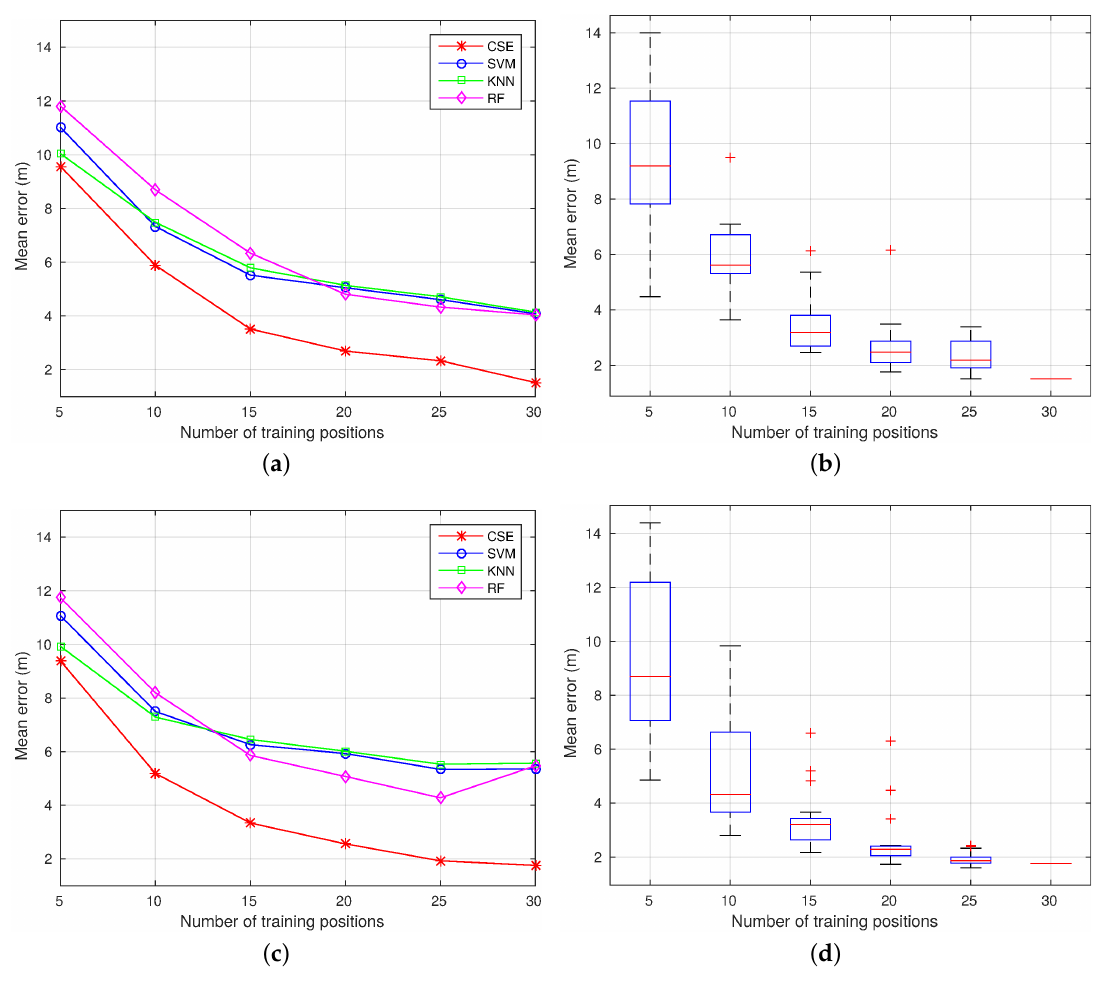
Figure 14. Mean error evolution changing the number of randomly-selected training positions. ( a ) Trajectory 1: mean error; ( b ) Trajectory 1: CSE boxplot; ( c ) Trajectory 2: mean error; ( d ) Trajectory 2: CSE